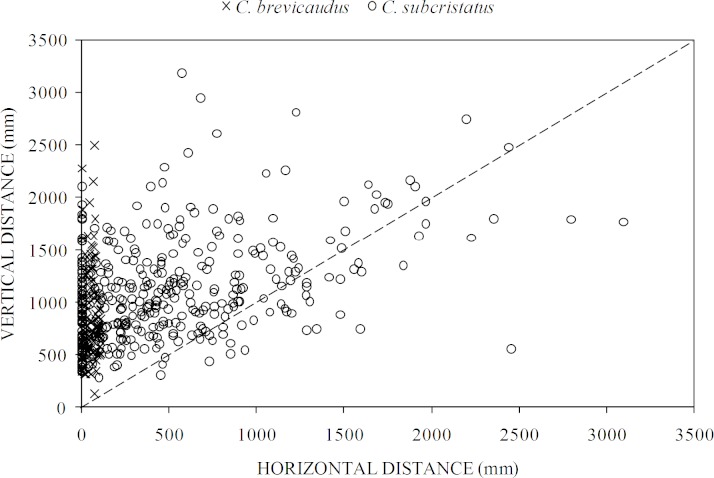
Relative contribution of horizontal distance (perch distance from trunk) and vertical distance (perch height) to the total distance moved.Relationship between horizontal distance (perch distance from trunk) and vertical distance (perch height) in Coryphophylax subcristatus (n = 372) and C. brevicaudus (n = 114). The dashed line shows the 1:1 correspondence between the two axes.